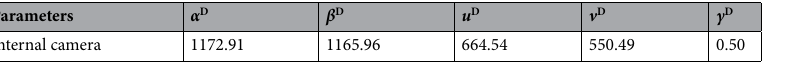
Table 2. Intrinsic parameters of the internal camera. α D , β D are the pixel-dimension focal lengths of the internal camera in x and y direction. γ D is the skew parameter. u D , v D are the pixel-dimension coordinates of the principal point.